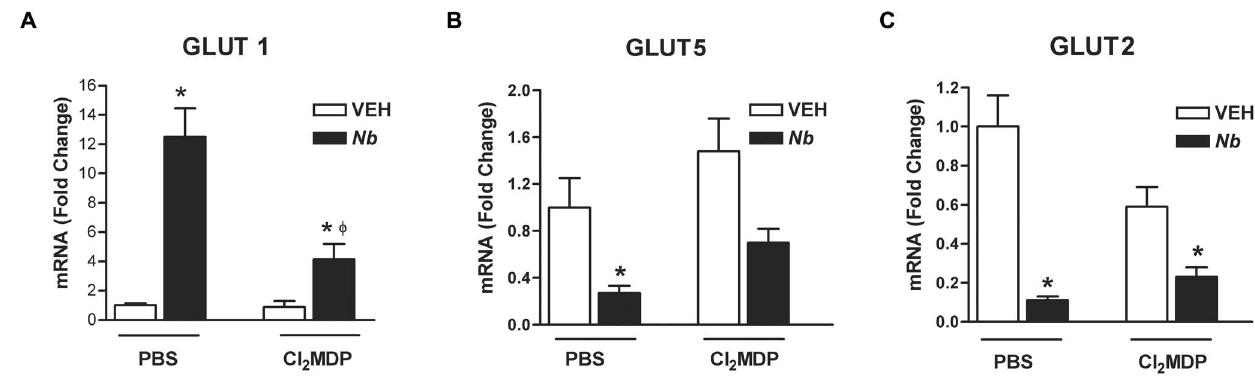
Figure 3. The effect of macrophage depletion on N.brasiliensis infection-induced changes in the expression of glucose transporters. WT mice were given PBS or clodronate (Cl 2 MDP) containing liposomes to deplete macrophages and one day later treated with vehicle (VEH) or infected with N. brasiliens is (Nb). At day nine post inoculation, full thickness sections of small intestine were prepared for real-time qPCR to measure the mRNA expression of glucose transporters. Values shown are means 6 SE; *p , 0.05 vs VEH Control; w p , 0.05 vs N. brasiliensis infected mice treated with PBS-containing liposomes.